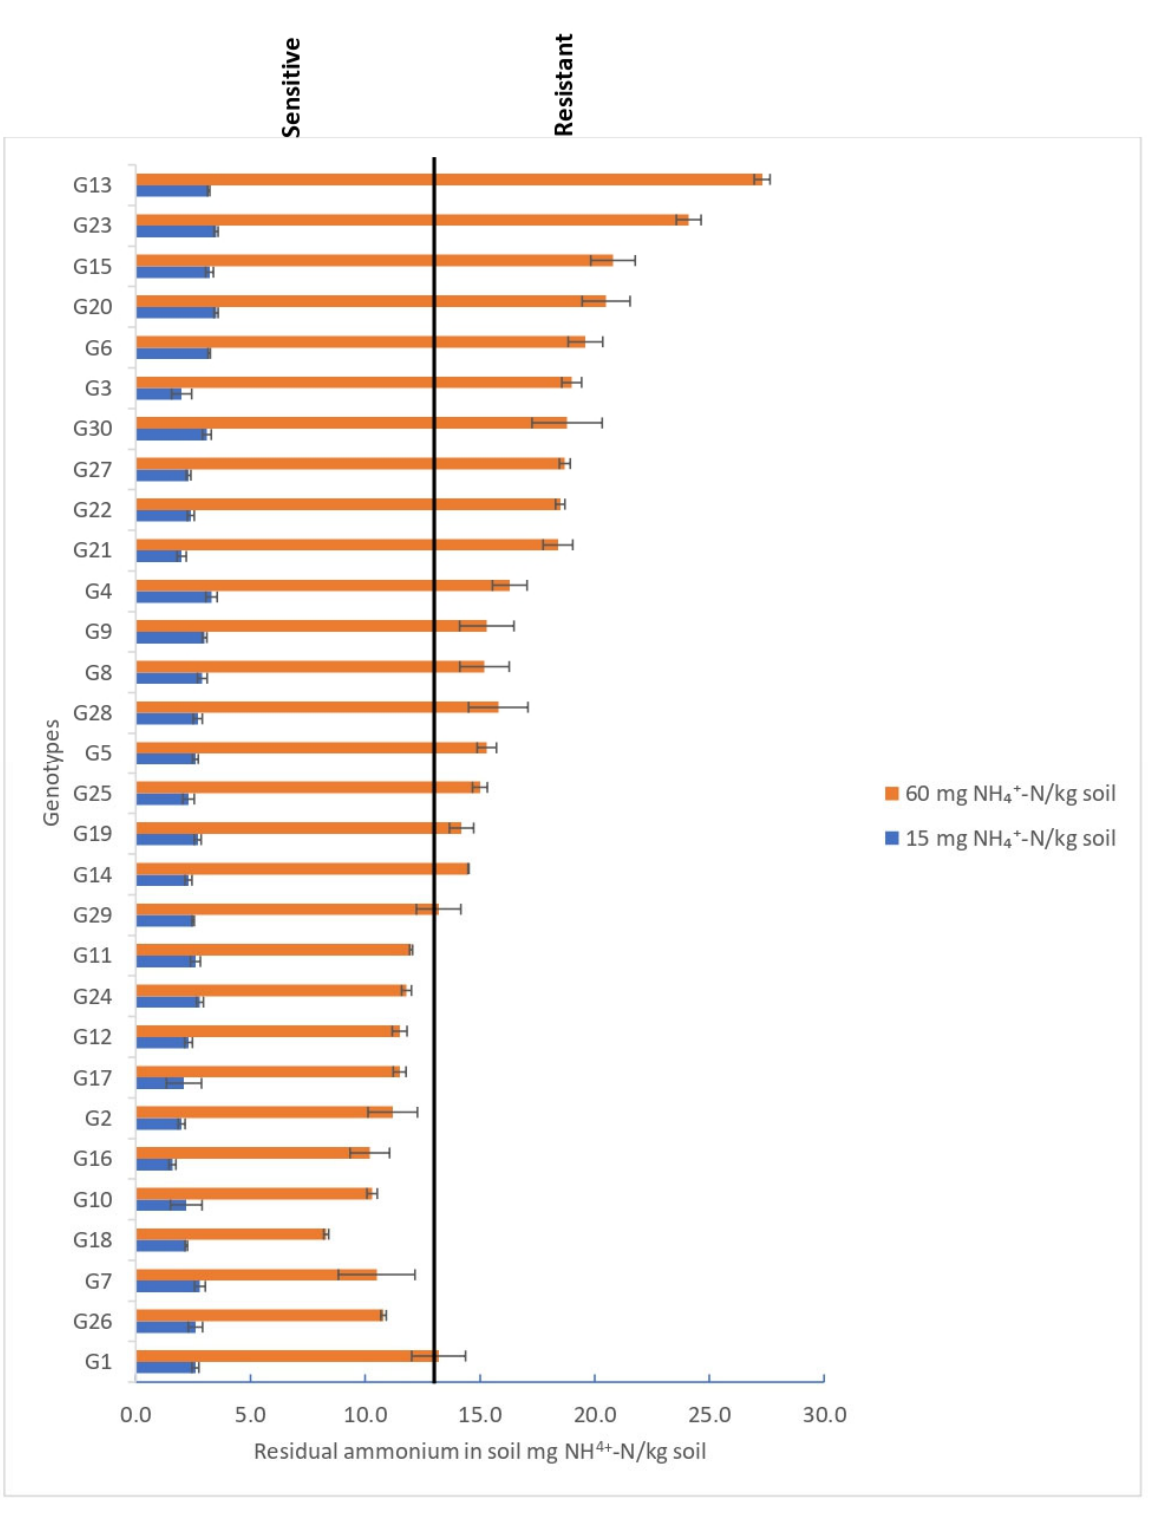
Figure 6. Residual soil ammonium (mg NH 4+ -N/kg soil) after growth of 30 canola genotypes (starting rates of NH 4+ -N soil application of 60 and 15 mg NH 4+ − N/kg soil). The resistance intervals were defined by subtracting or adding the value of two standard errors (for the genotype main effect) from the median point for all the genotypes. Means ± SE (n = 3).